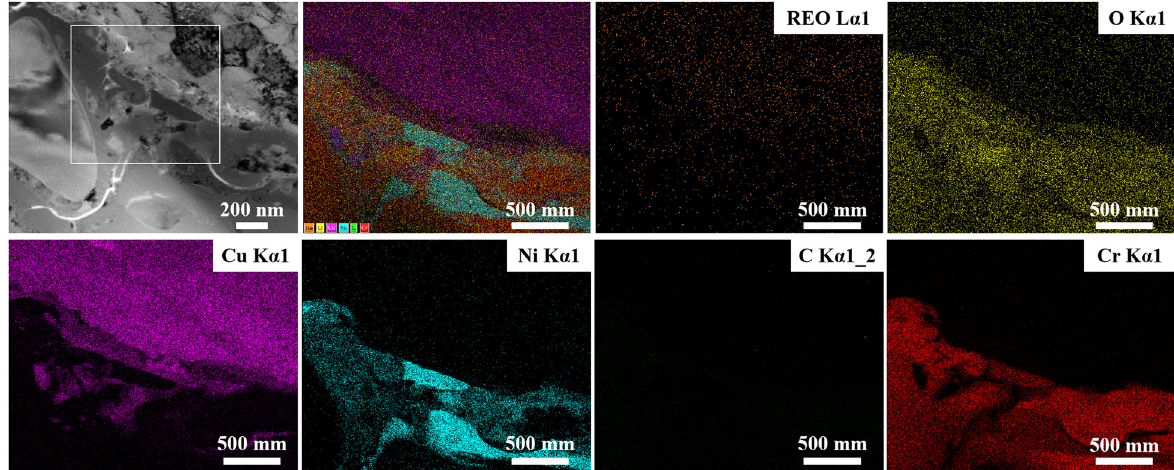
Figure 8: TEM micrograph and EDS elemental mapping for MC